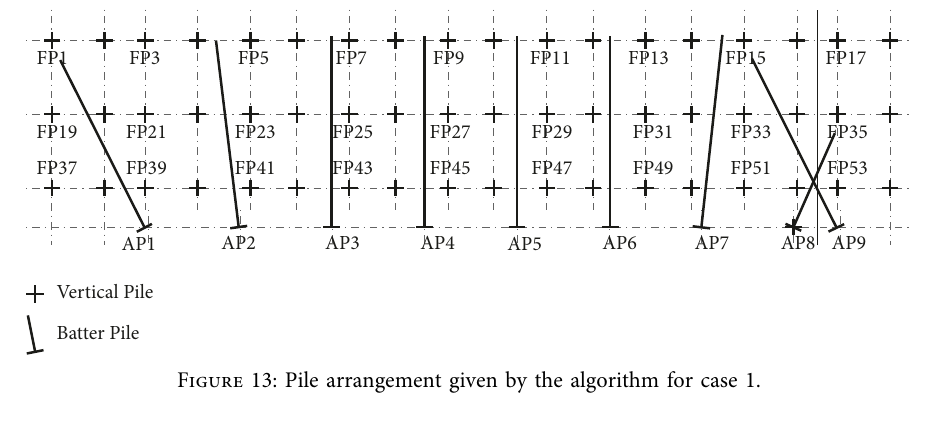
Figure 13: Pile arrangement given by the algorithm for case 1.